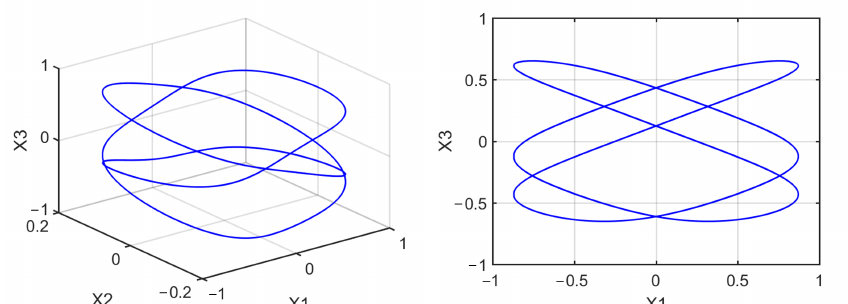
Figure A12. Periodic-3 motion of σ 1 = 0.7983.